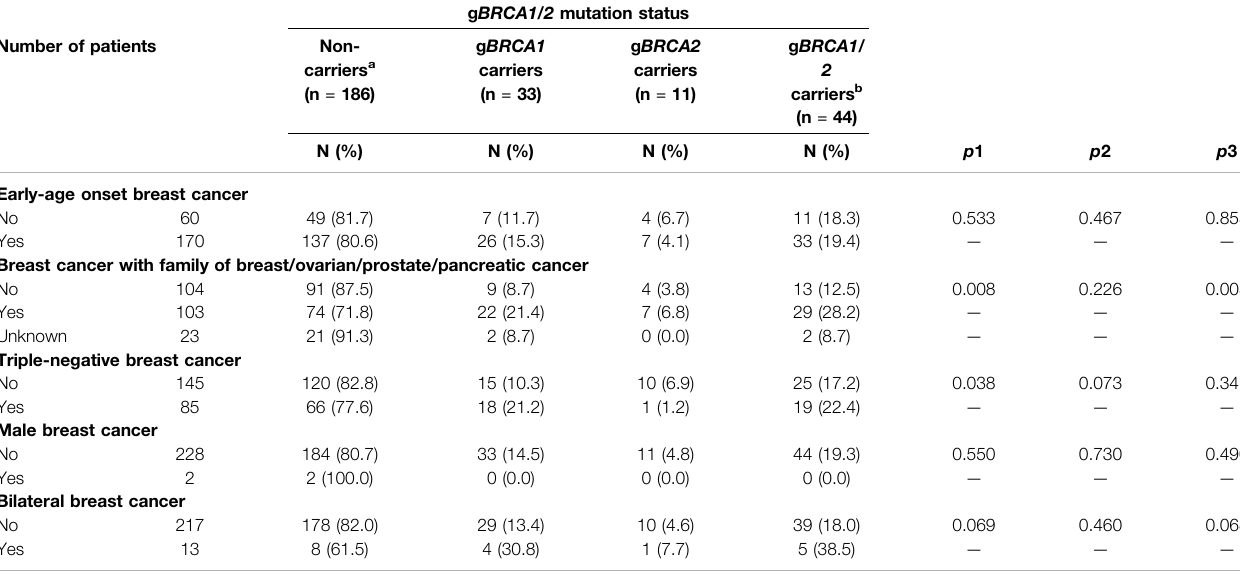
Mutationsidenti fi edas pathogenicorlikelypathogenicwereenrolledin our analysis. p 1, non-carriersversusg BRCA1 carriers; p 2,non-carriersversus g BRCA2 carriers; p 3, non-carriers versus g BRCA1/2 carriers. Bold values denote two-sided p < 0.05. a Non-carriers included all patients without BRCA , mutation. b BRCA1/2 carriers included g BRCA1 carriers and g BRCA2 carriers.